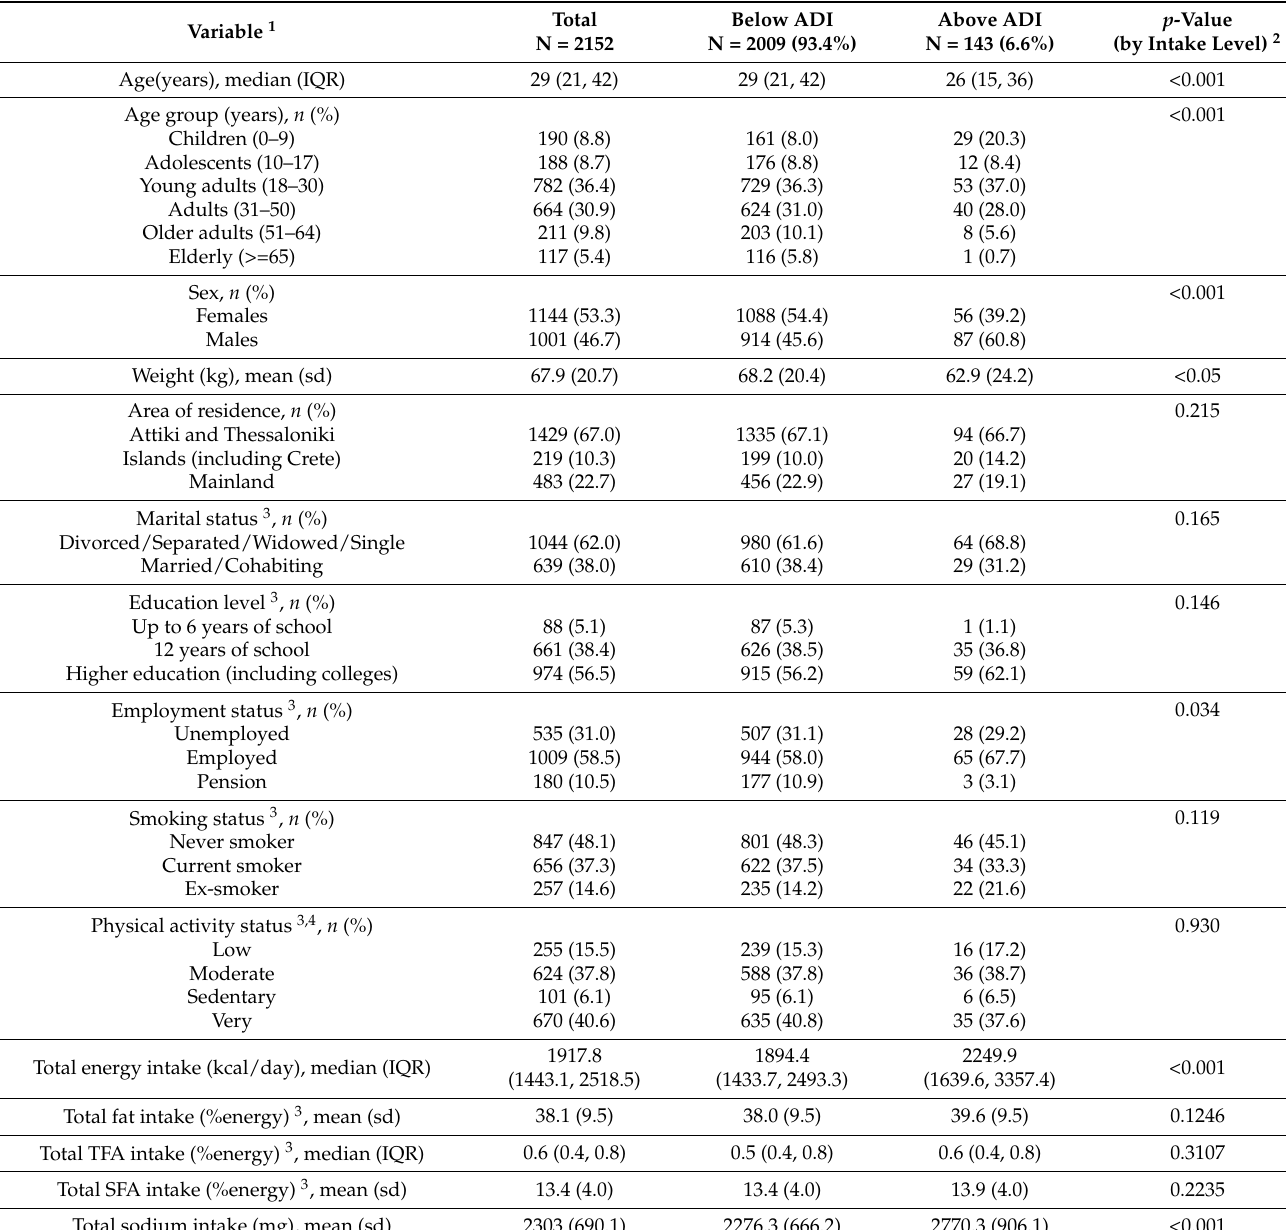
Table 2. Baseline variables of the participants by level of intake (above and below ADI of 0.07 mg/kg